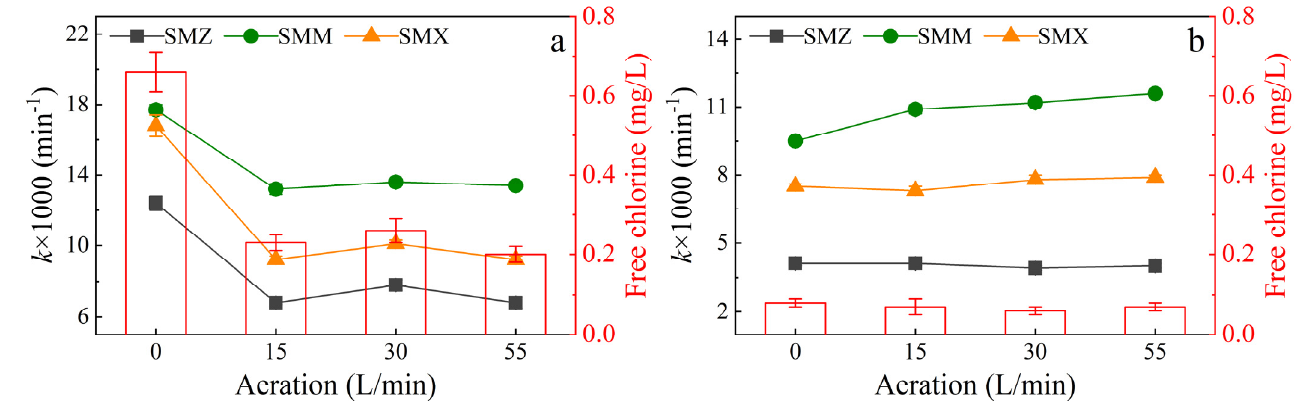
Figure 1. Pseudo-first-order kinetic rate constant ( k ) for sulfonamide degradation after 120 min. Conditions: aeration rate of 0, 15, 30, or 55 L/min, UV power of 48 W, and initial pH of 8.3. ( a ) Cl − concentration of 50 mg/L and current of 1.8 A (4.8 mA/cm 2 ). ( b ) Cl − concentration of 20 mg/L and current of 1.0 A (2.7 mA/cm 2 ).